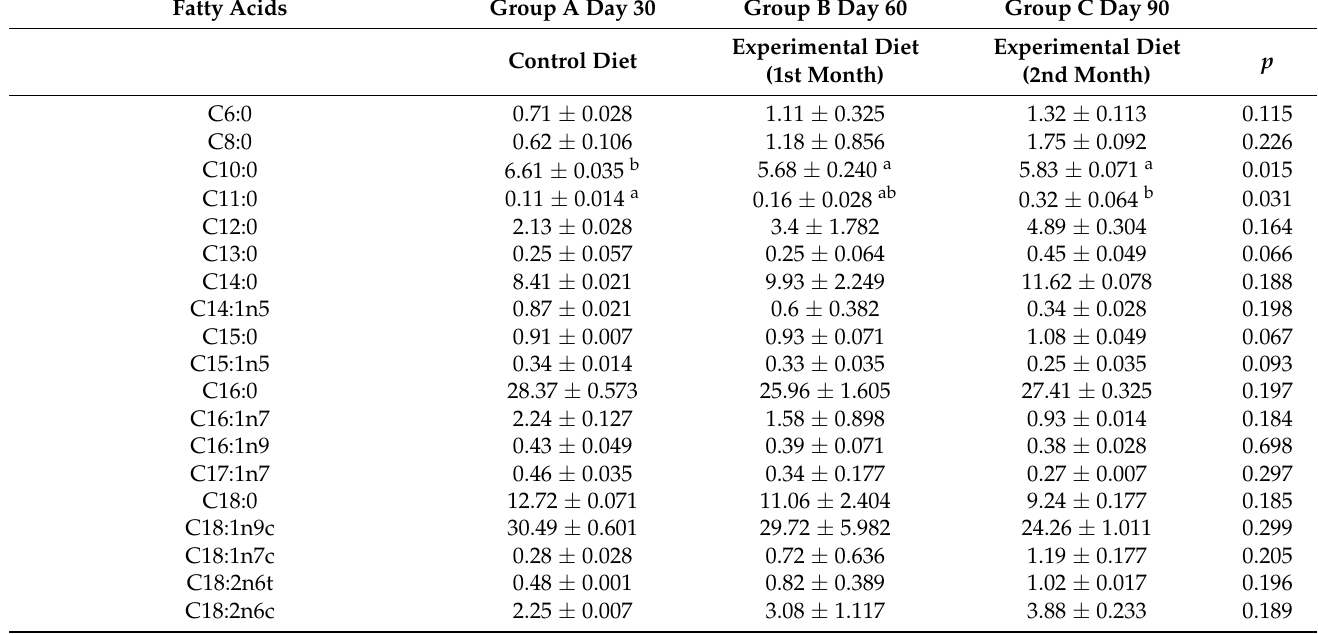
Table 3. Fatty acid profile of the Kefalograviera cheese samples (% of total fatty acids ± stan- dard